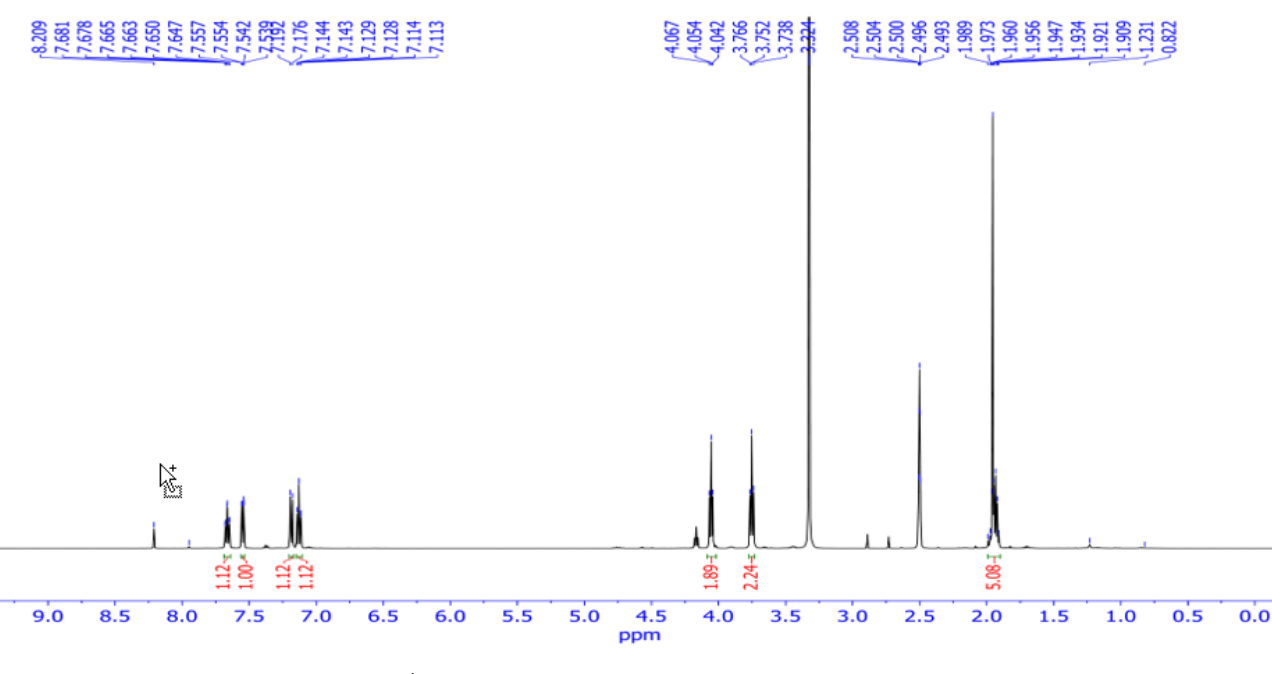
Figure 1. Comparisons of IR spectra of N -(3-bromopropyl) isatin 4g ( A ) and N -(3-azidopropyl) isatin 5g ( B ).